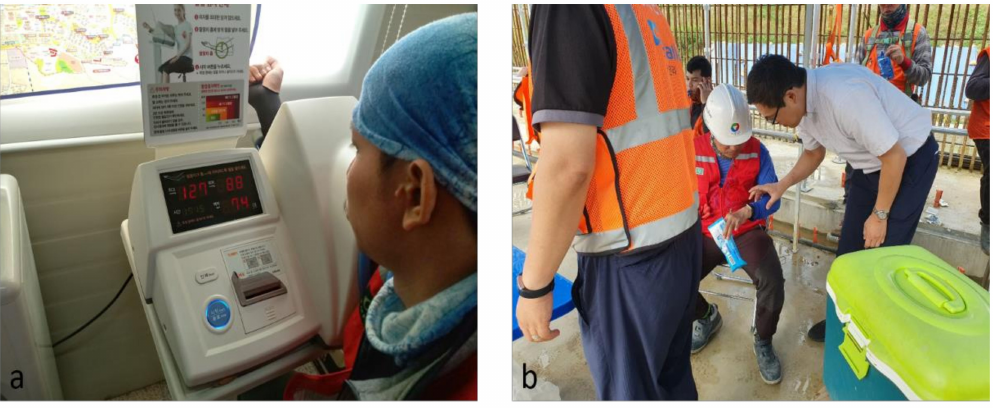
Figure 12. Outdoor validation test: ( a ) heartbeat comparison and ( b ) calibration of the